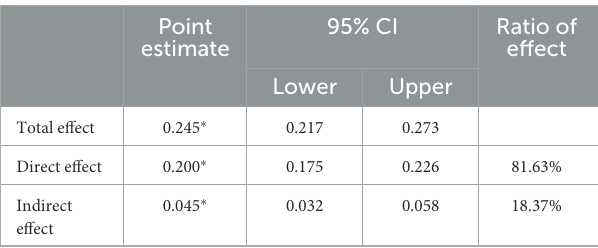
TABLE 5 Mediating effect of self-efficacy between media use and health literacy.